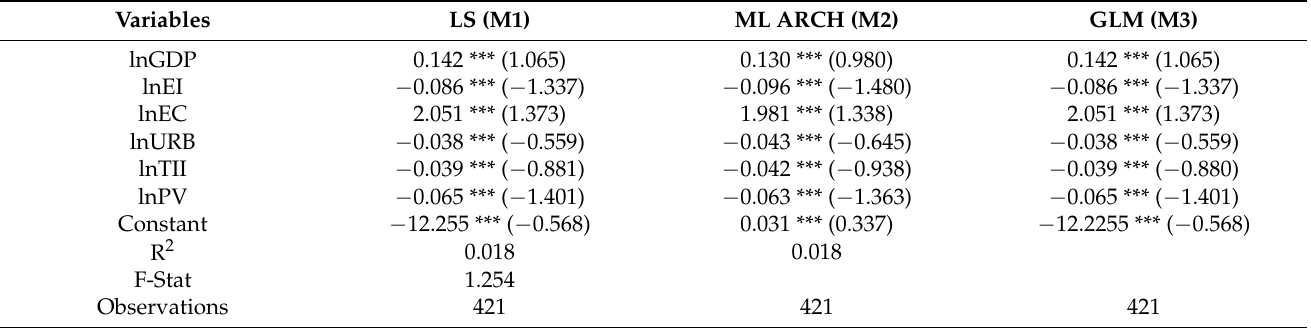
Table 7. Panel estimation results: National case for three provinces of CO 2 - eq emissions in the transport